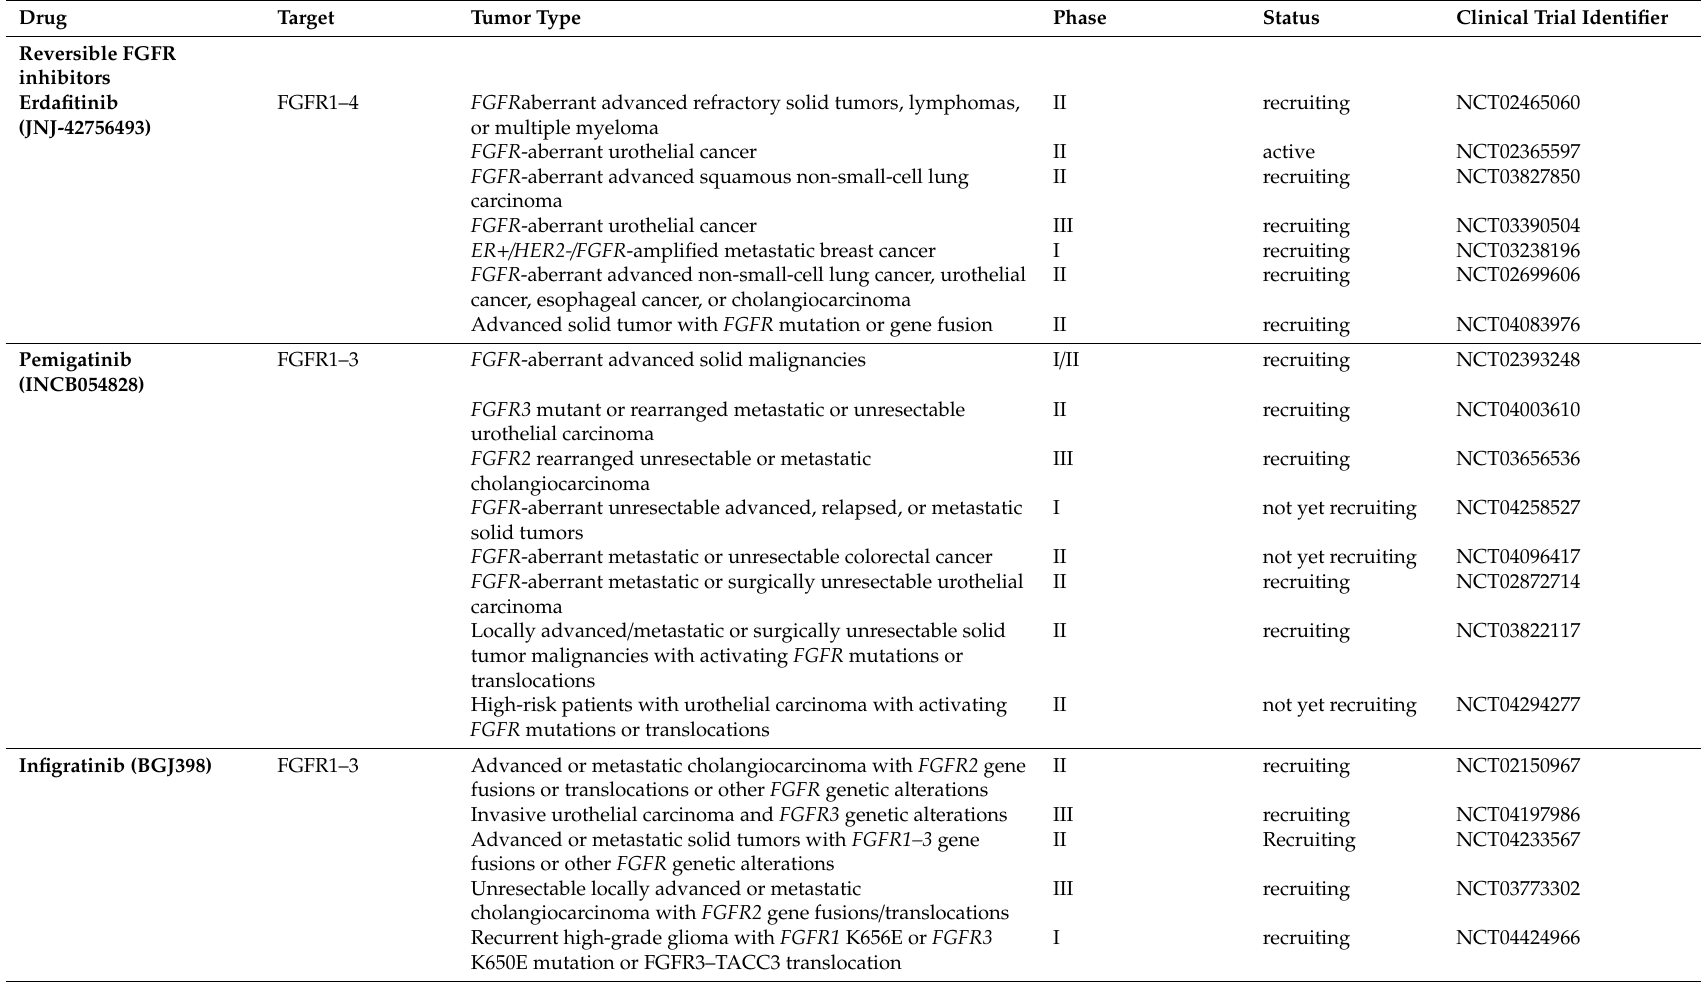
Table 4. Clinical trials with selective FGFR